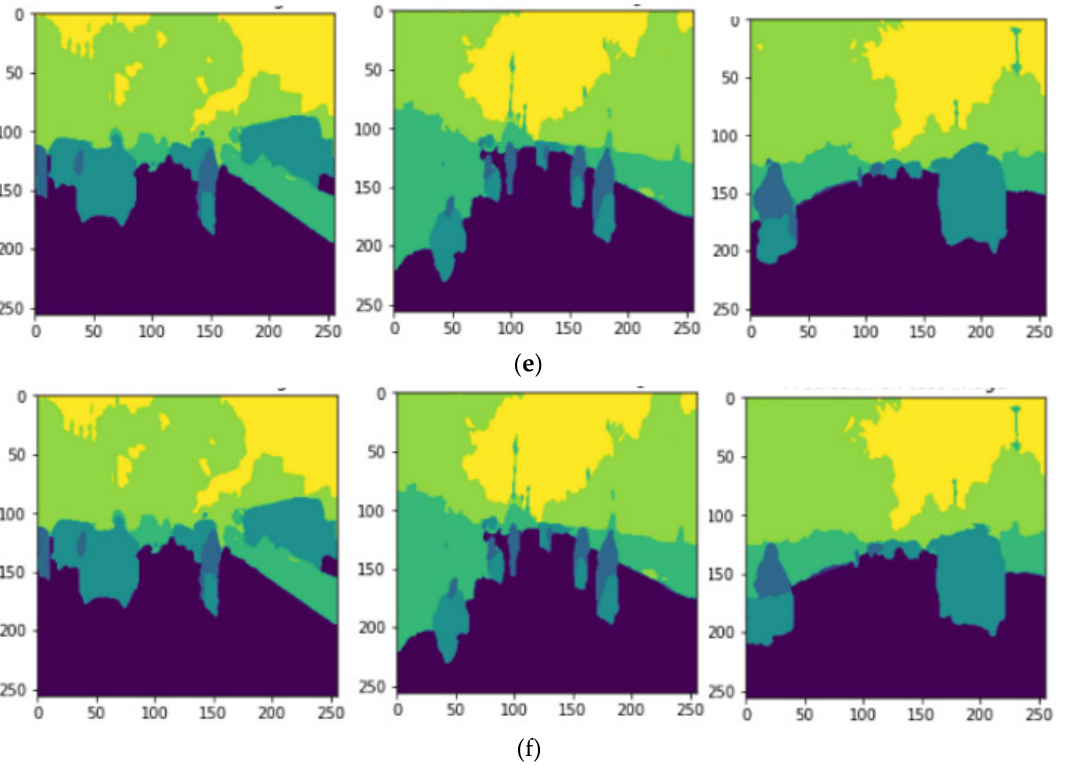
Figure 6. Results from our four weight-ensembled Segmentation Models in the IDD-Lite dataset. ( a ) Different input images to the network representing various conditions from an unstructured envi- ronment; ( b ) ground truth values for the input data; ( c ) predicted segmentation results in U-Net weight-ensembled , with different colours indicating different classes in the image; ( d ) LinkNet weight-ensembled prediction; ( e ) PSPNet weight-ensembled prediction; and ( f ) FPN weight-ensembled prediction. Table 5. IoU Value and F1 score obtained by the ensembled Segmentation